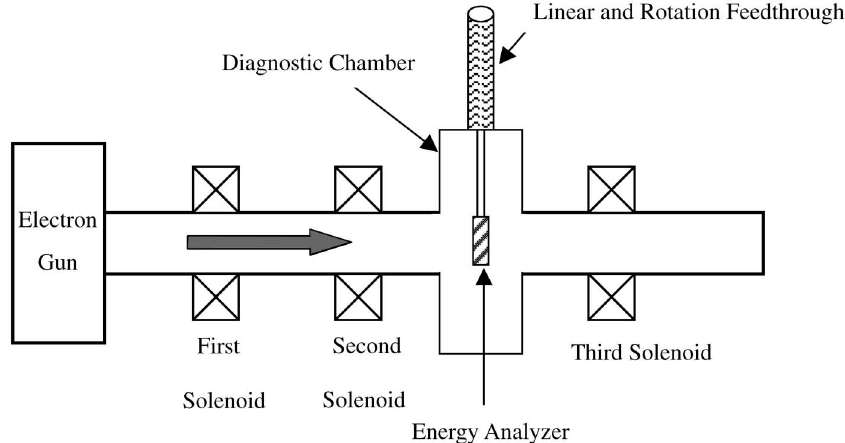
FIG. 6. Experimental setup for the energy analyzer test.